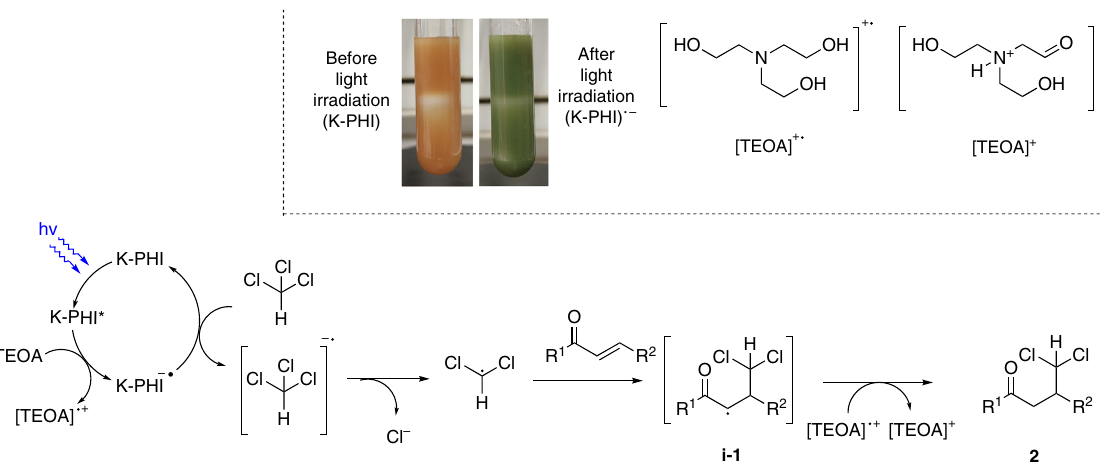
Fig. 6 Proposed mechanism of the generation of dichloromethyl radicals and their addition to enones. Inset shows images of the reaction mixture before and after light irradiation and structures of TEOA oxidation